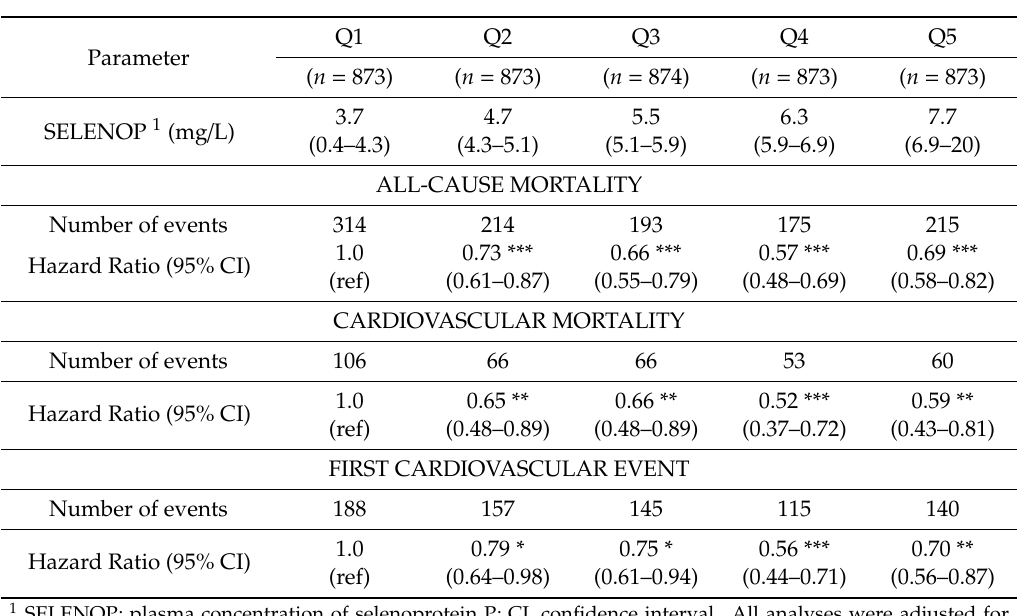
Table 2. Population quintile (Q) of SELENOP in relation to all-cause mortality, cardiovascular mortality and a first cardiovascular event in subjects without history of cardiovascular disease at baseline in multivariate adjusted